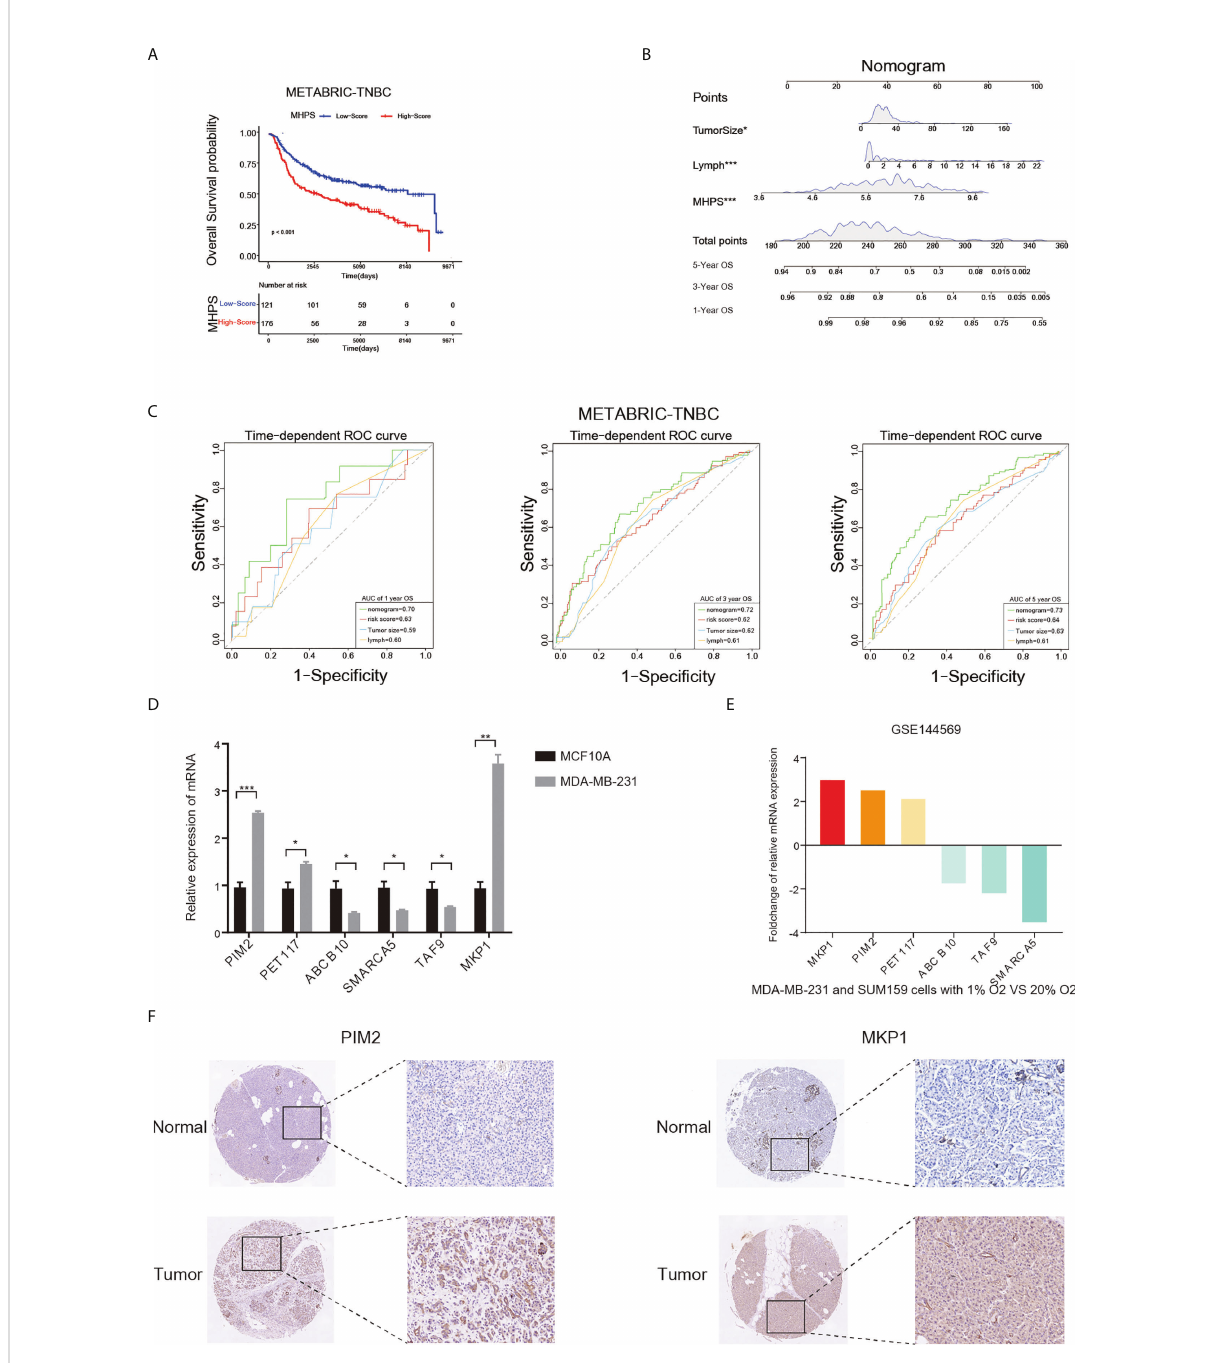
FIGURE 9 Nomogram and detection of MHPS gene expression. (A) Kaplan-Meier analysis of patients with high or low MHPS risk socre in METABRIC-TNBC cohort. (B) Construction of nomogram scoring system to predict patient survival at 1-, 3- and 5- years. Each clinical factor in the nomogram system corresponds to a score, and all scores are summed to obtain a total point, which can predict the survival rate of patients at 1-, 3- and 5- years. (C) Time-dependent ROC for the nomogram, MHPS, tumor size, lymph node in the METABRIC cohort (for predicting 1, 3, and 5-years OS). (D) Comparison of mRNA expression of hub genes in normal breast and TNBC cell lines. (E) Different expression of hub genes in normoxia and hypoxia cultured TNBC cells based on GSE144569 dataset. (F) IHC staining to detect protein expression of PIM2 and MKP1 in normal and tumor tissues. Scale bar:100 m m.(*P< 0.05,**P< 0.01, and ***P< 0.001). ns, not signi fi